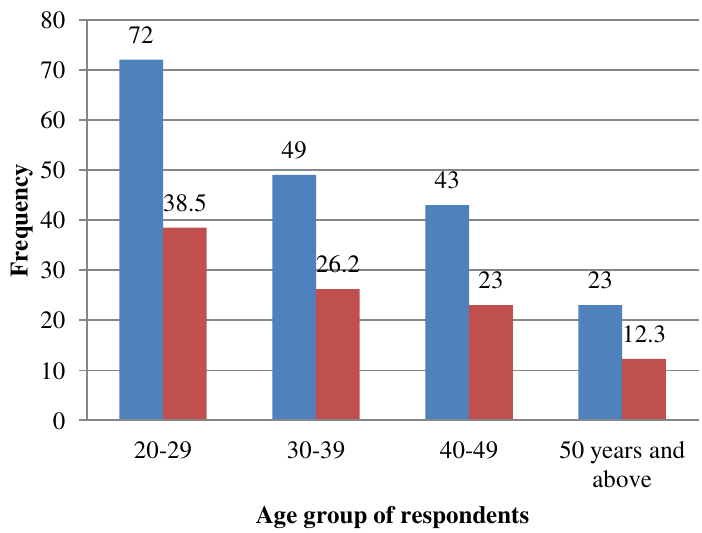
Fig. 1. Frequency and percentage on age group of research